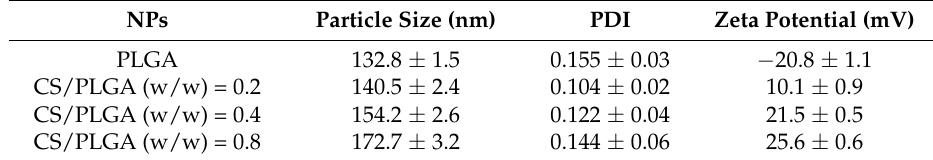
Table 1. Particle size, polydispersity index (PDI), and zeta potential of nanoparticles (NPs).